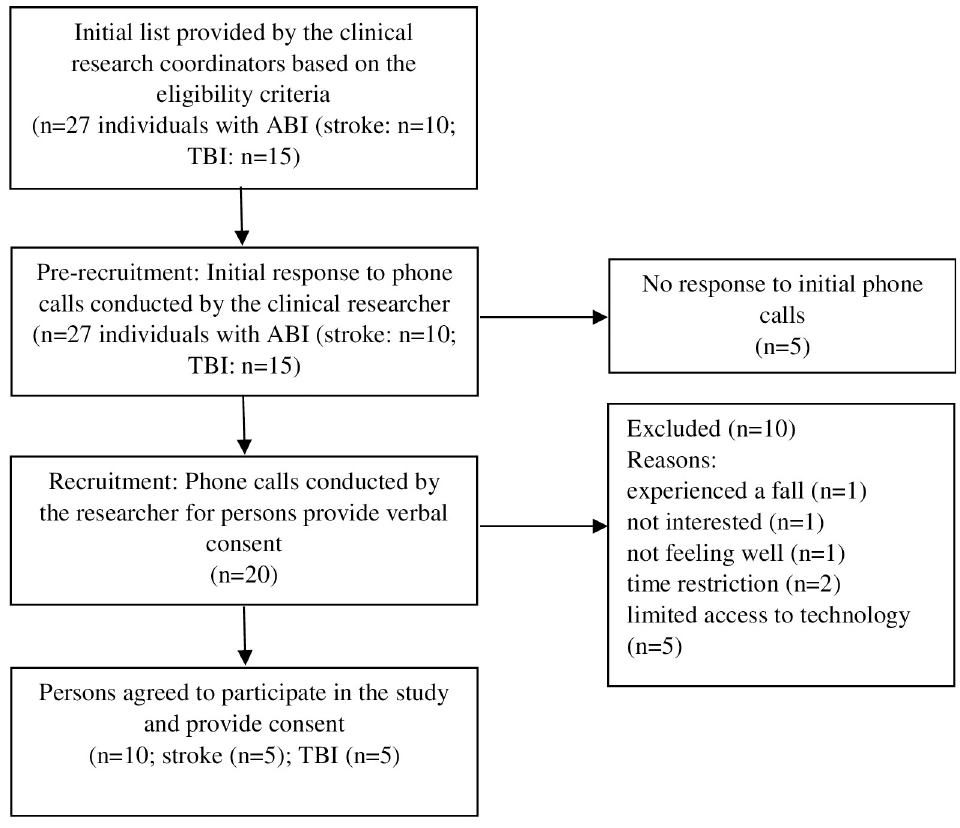
Fig 1. The recruitment process for individuals with acquired brain injury